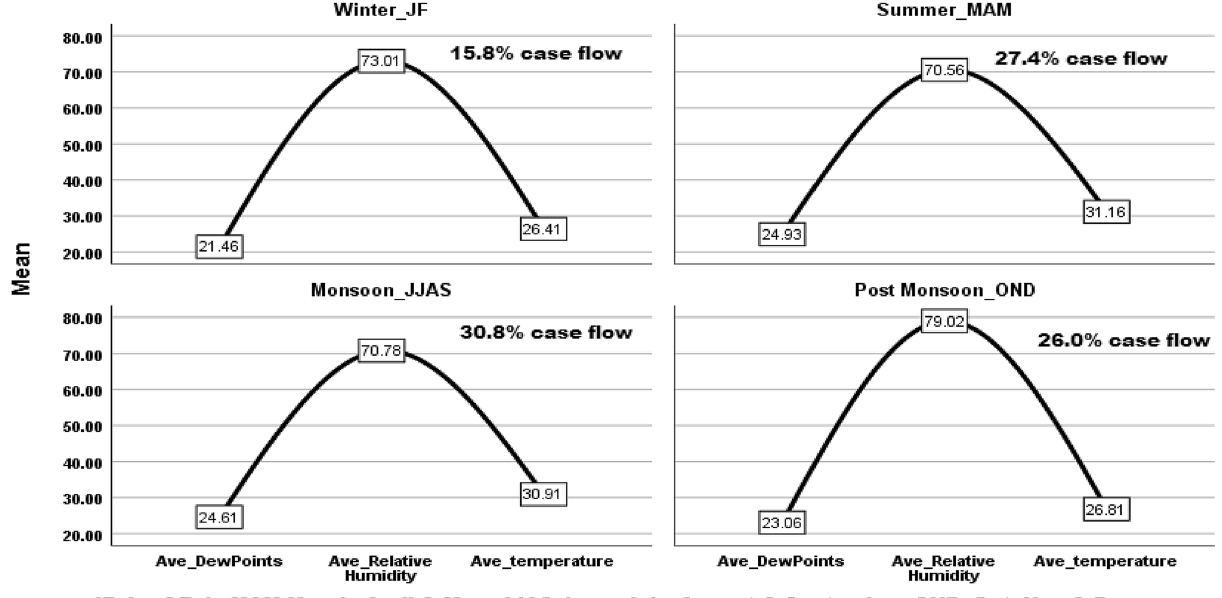
Figure 1. High patient flow in the monsoon and summer seasons and a high drop in the winter season. Method : Group line chart focusing climate factors. Results : The patient flow in all seasons and variability in climate factors were explained.